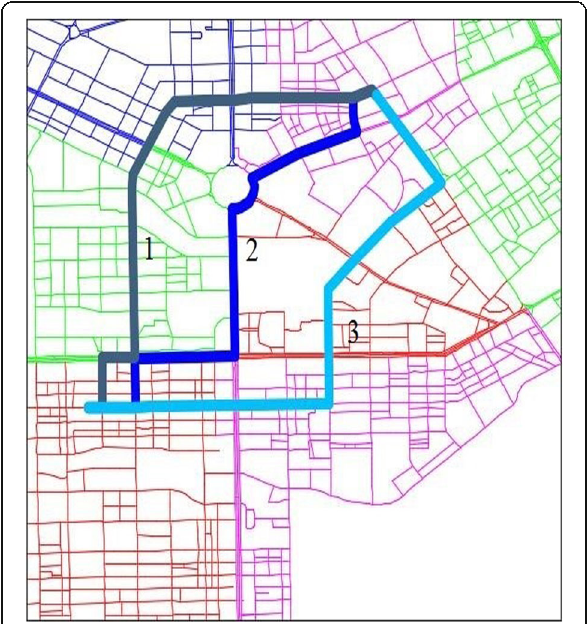
Fig. 6 The results of different guidance path